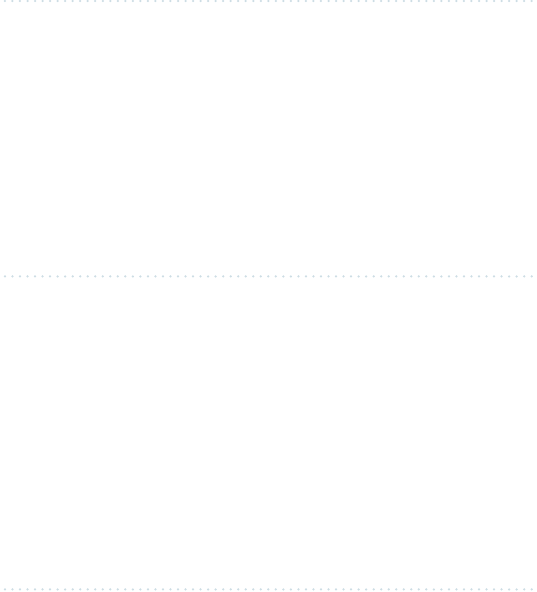
Figure 8. Comparison of convergence rates between different prediction methods.